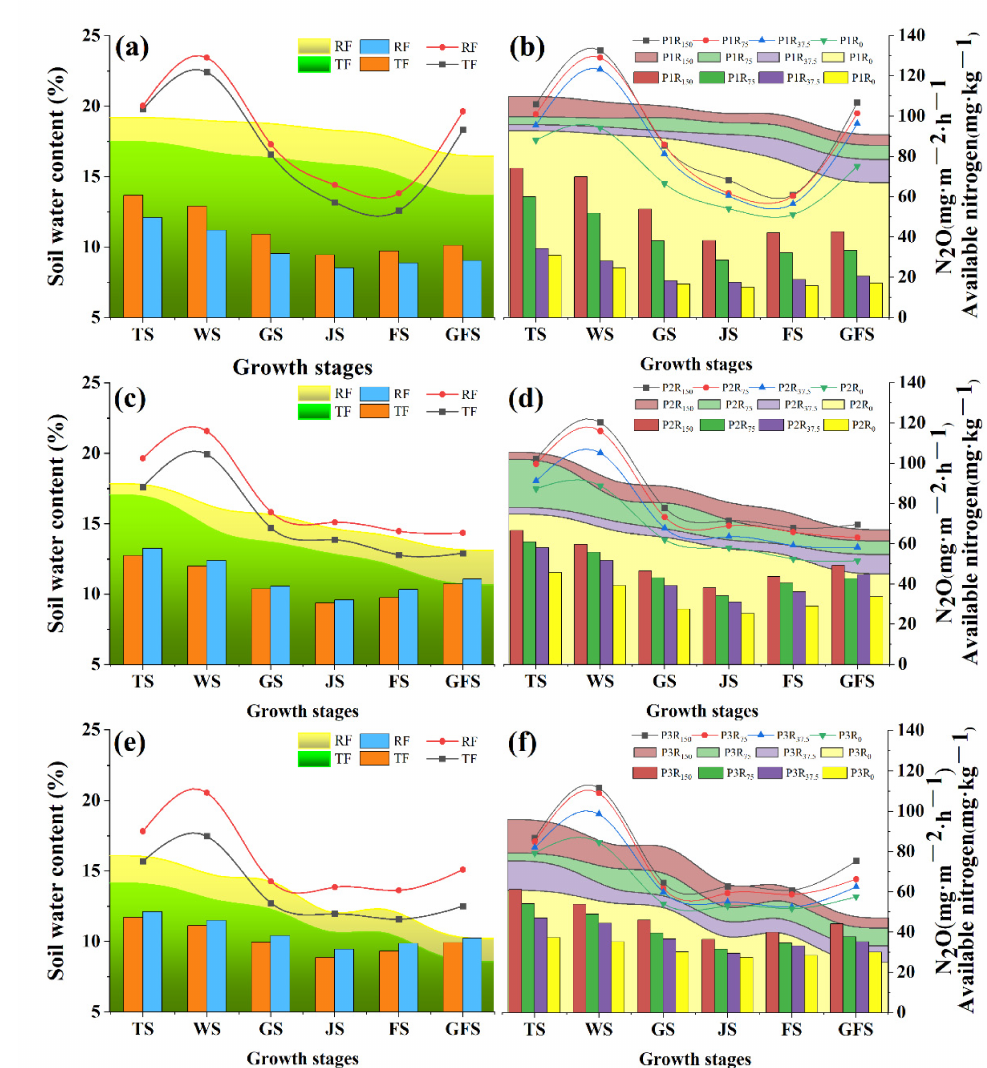
Figure 3. Effects of planting models and limited irrigation on the N 2 O rate, soil water content, and available nitrogen under simulated rainfall conditions during the winter wheat growing